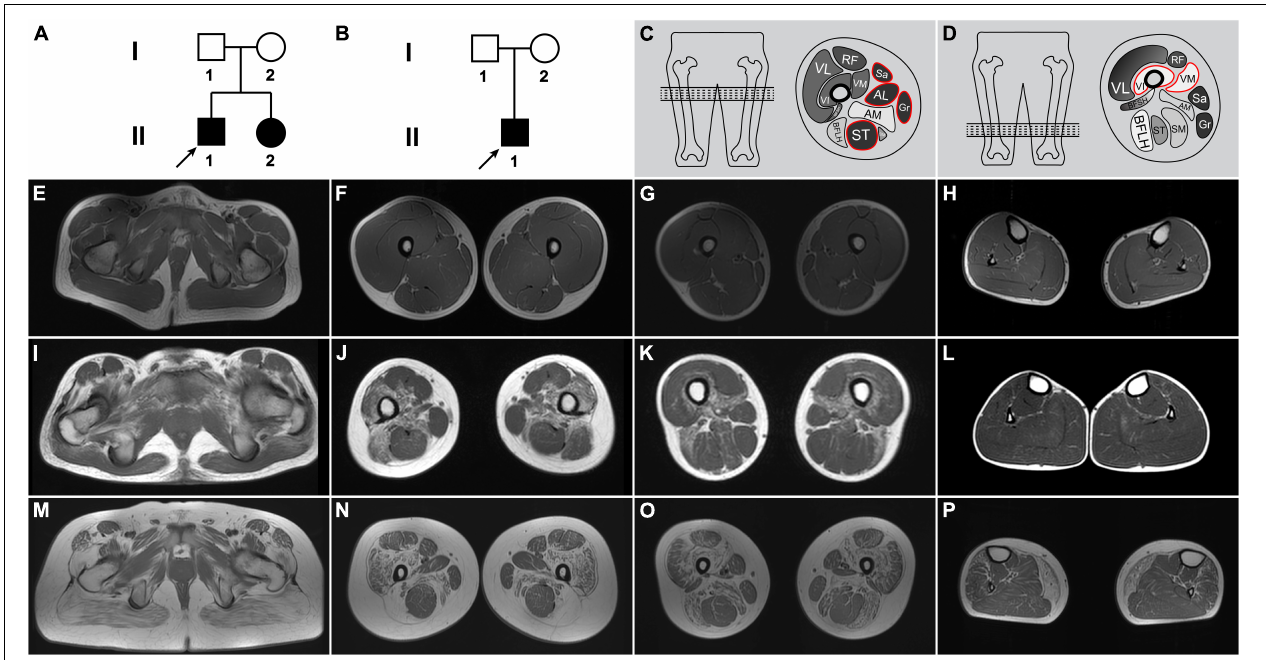
FIGURE 1 | Pedigrees and muscle T1-weighted images of patients with beta-sarcoglycanopathy. (A) Family 1. (B) Family 2. Each family member was identified with a pedigree number. Affected members colored in black. The black arrow indicated the proband for each family. Schematics of the trefoil with single fruit sign (C) and the concentric fatty infiltration pattern (D) . (E–H) A healthy control. (I–L) Patient F1-II1. (M–P) Patient F2-II1. (I) An axial T1-weighted image of pelvis muscles of patient F1-II1 showing moderate fatty infiltration of the pectineus and obturator externus muscles. Axial T1-weighted images of patient F1-II1 showing moderate fatty infiltration of the adductor longus muscle at proximal thigh level (J) and the concentric fatty infiltration pattern around distal femoral diaphysis (K) , which consisted of severe fatty infiltration of the vastus medialis and vastus intermedius muscles with sparing of the vastus lateralis muscle (D) . (L) No obvious muscle fatty infiltration was observed in the lower leg muscles of patient F1-II1. (M) Mild fatty infiltration of the pectineus and tensor fasciae latae muscles and severe fatty infiltration of the gluteus maximus muscle were observed in patient F2-II1. Axial T1-weighted images of patient F2-II1 showing the concentric fatty infiltration pattern (O) and the trefoil with single fruit sign at proximal thigh level (N) , which consisted of three leaflets formed by relative sparing of the adductor longus, sartorius, and gracilis muscles and one single fruit formed by sparing of the semitendinosus muscle (C) . (P) Severe fatty infiltration of the gastrocnemius medialis muscle was observed in patient F2-II1. RF, rectus femoris; VL, vastus lateralis; VI, vastus intermedius; VM, vastus medialis; Sa, sartorius; AL, adductor longus; Gr, gracilis; AM, adductor magnus; BFSH, biceps femoris, short head; BFLH, biceps femoris, long head; ST, semitendinosus; SM,